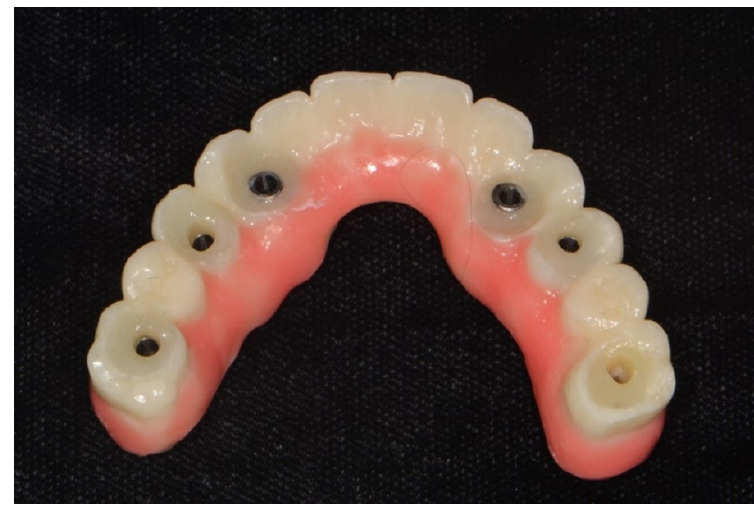
Figure 6. Interim prosthesis after sectioning the denture flange part.